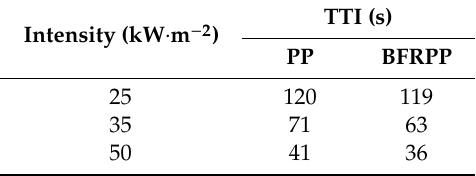
Table 6. Time-to-ignition (TTI) of PP and BFRPP samples under di ff erent heat